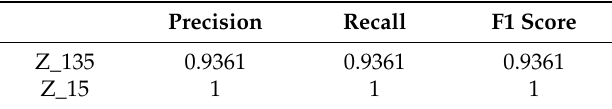
Table 4. CGRU model results for Z_135 and Z_15